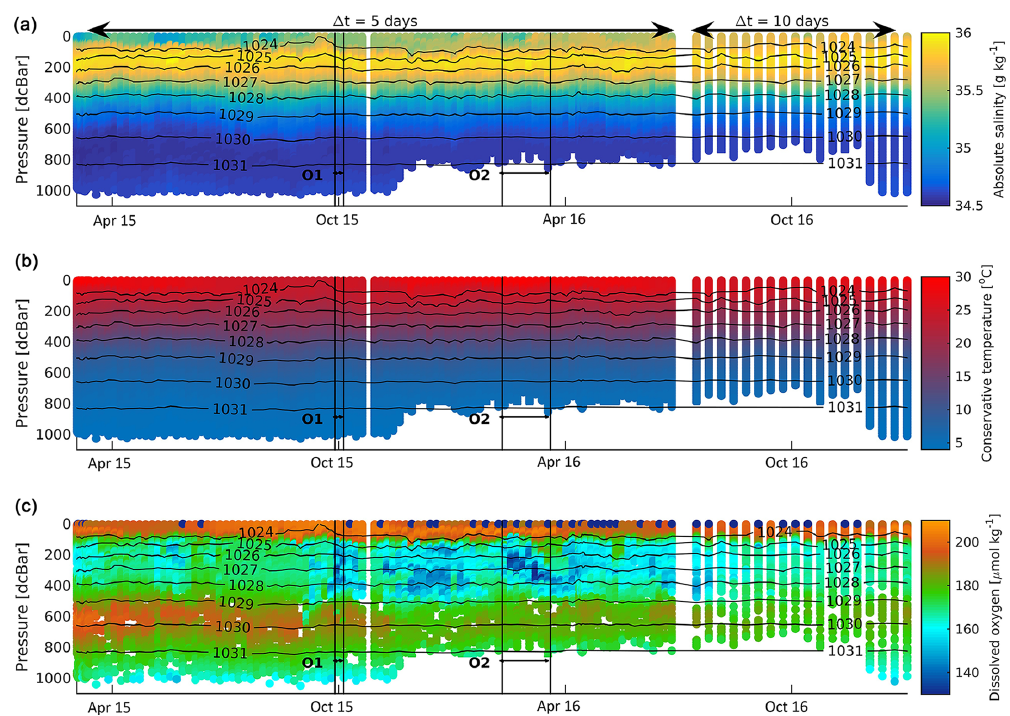
Figure 4. Profiles of float 656 over depth and time for (a) absolute salinity, (b) conservative temperature and (c) dissolved oxygen concen- tration. Every colored point corresponds to a measurement. The horizontal black lines indicate the isopycnals from 1024 to 1031kgm − 3 . The vertical black lines indicate the limits of the low-oxygen events O1 and O2. Over the top of (a) , (cid:49)t indicates the two different sampling frequencies of the